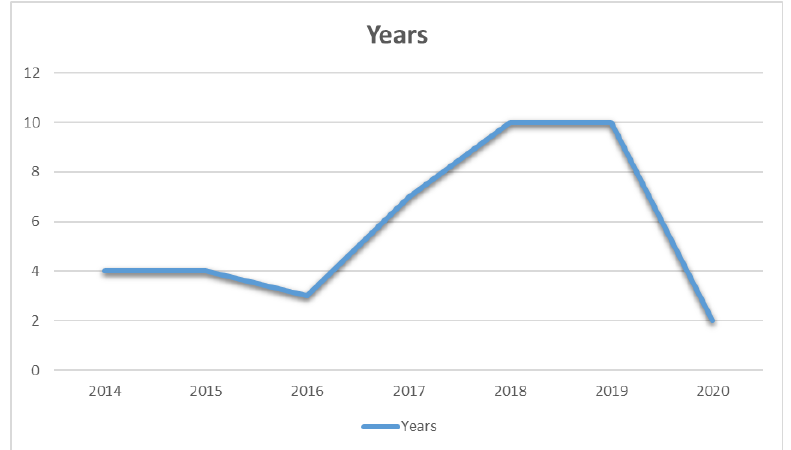
Figure 4. Distribution based on publication year.